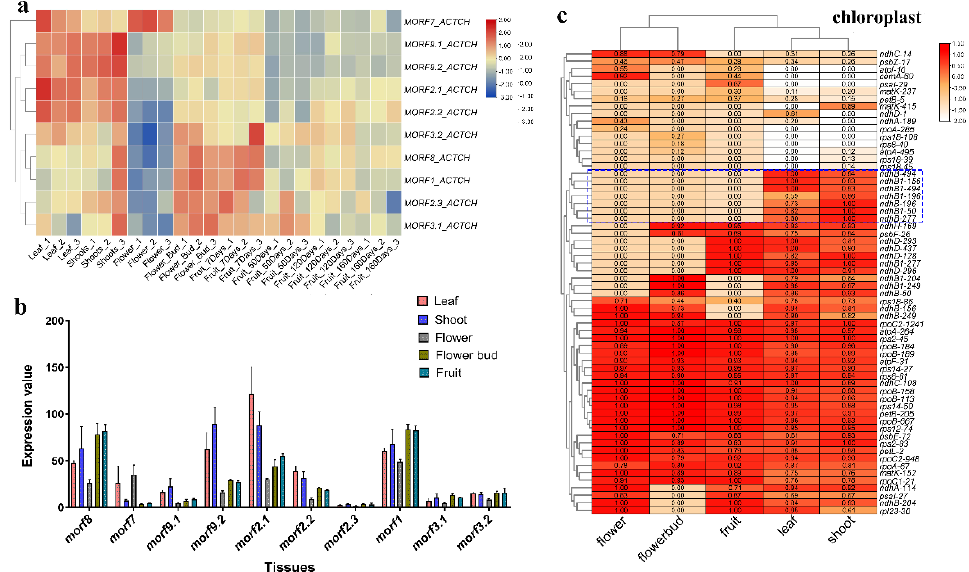
Figure 6. Expression and RNA editing pattern of MORF genes in kiwifruit among different tissues. ( a ) Heat mapping of MORF gene expression in different tissues of kiwifruit. The x-axis represents different samples (leaf, shoot, flower, flower bud, and fruits at different developmental stages), the y-axis represents MORF genes. The rows were clustered based on expression values. ( b ) Expression level of ten MORF genes in kiwifruit among different tissues. Tissues are indicated by different colors. ( c ) Heat mapping of RNA editing efficiency in kiwifruit chloroplast genes among different tissues. The x-axis represents different tissues, the y-axis represents chloroplast RNA editing sites, and the rows are clustered based on RNA editing efficiency. Editing sites occurring in ndhB gene are marked by a blue box.